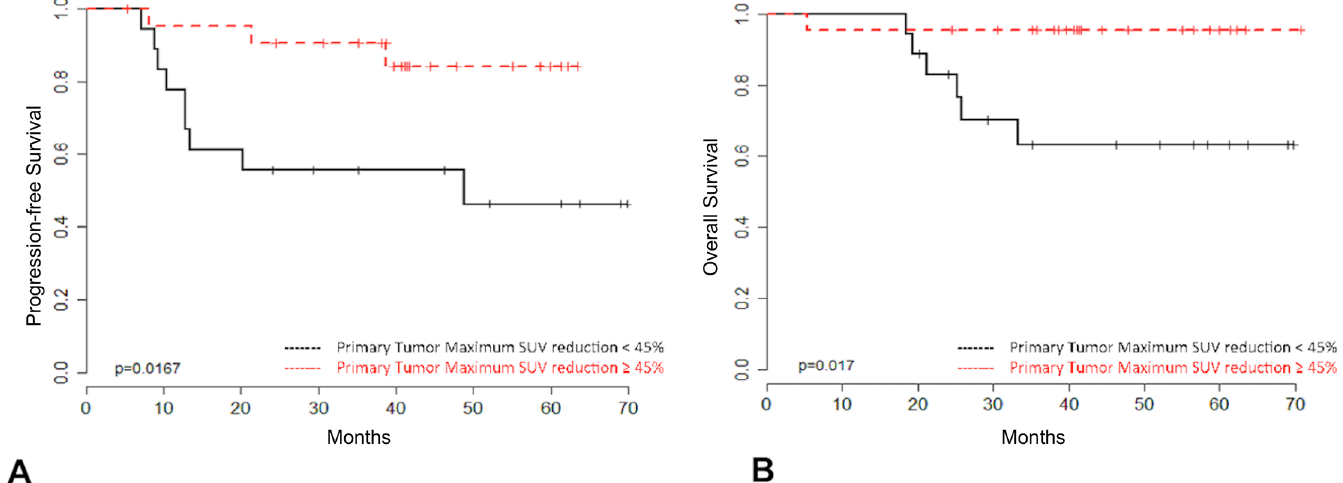
Fig 4. Clinical outcome according to primary tumor SUV extent change after cycle 1 of IC. Progression-free survival (4A) and overall survival (4B) among responsive patients (neck lymph node SUV change (%) (cid:20) 0) according to the change in maximum primary tumor SUV after the first cycle of IC (N = 40). Patients with maximum primary tumor SUV reduction (cid:21) 45% (N = 22; red) showed improved outcomes compared with those with primary tumor uptake reduction < 45% (N = 18; black).